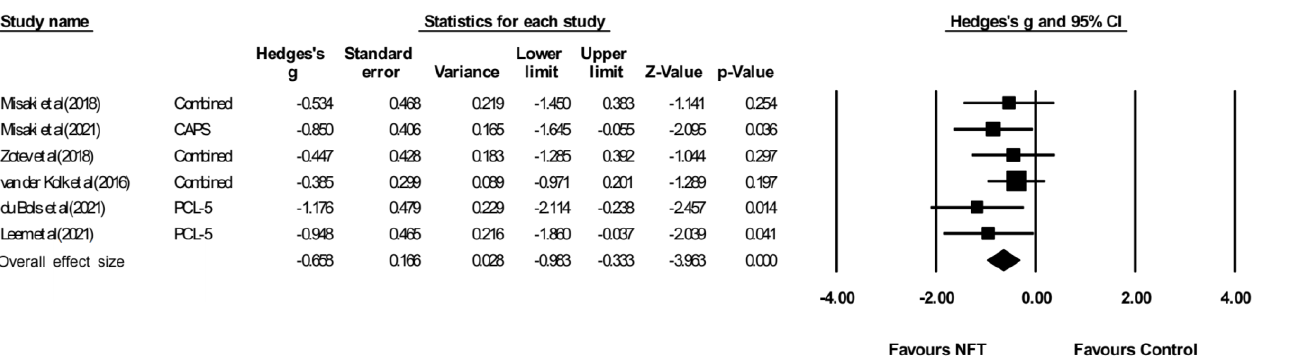
Figure 5. Forest plot for meta-analysis of the effect of neuro-feedback training on PTSD diagnosis.